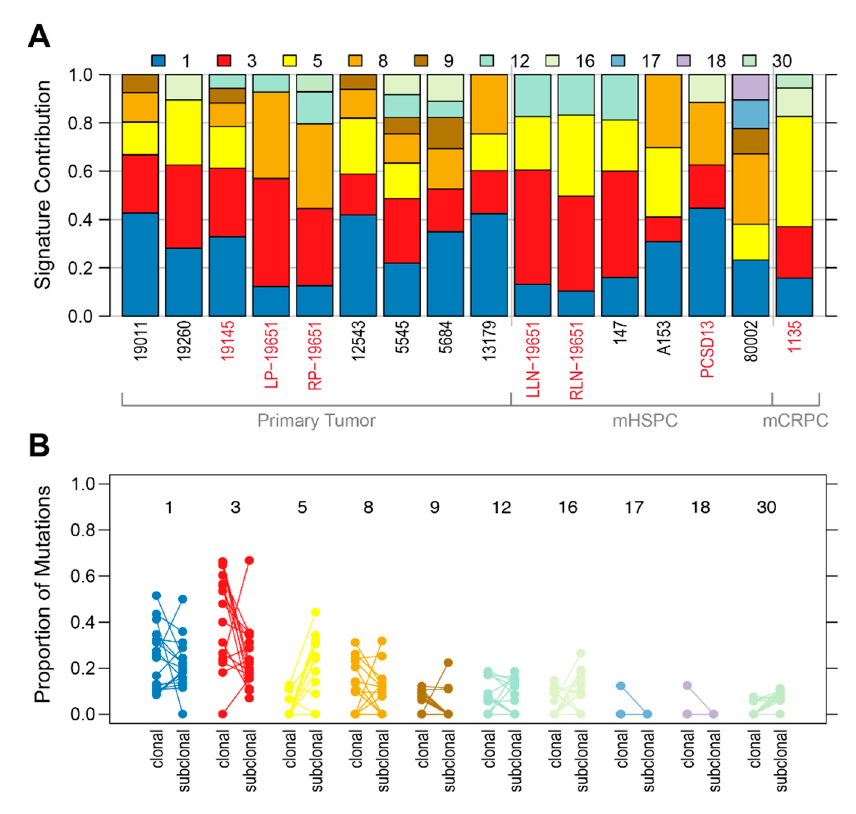
Figure 2. COSMIC Mutational Signatures ( a ) Proportion of signatures in each sample, for Signatures with >5% contribution; ( b ) Clonal vs. subclonal signature exposures. mHSPC: metastatic hormone-sensitive prostate cancer; mCRPC: metastatic castration-resistant prostate cancer.